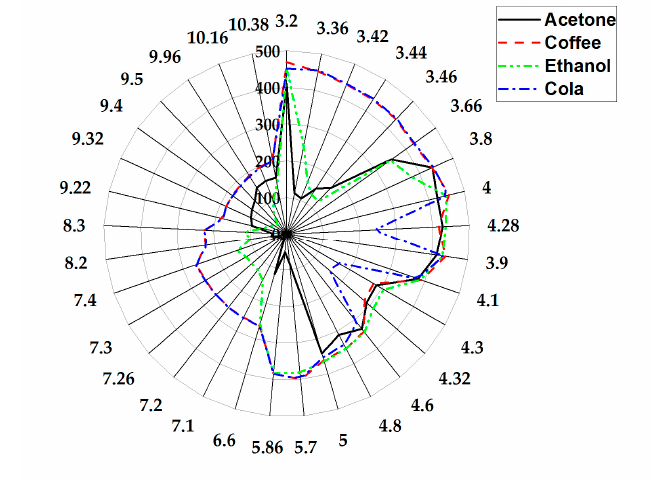
Figure 3. Radar plot of the raw sensors responses at different wavelength for different